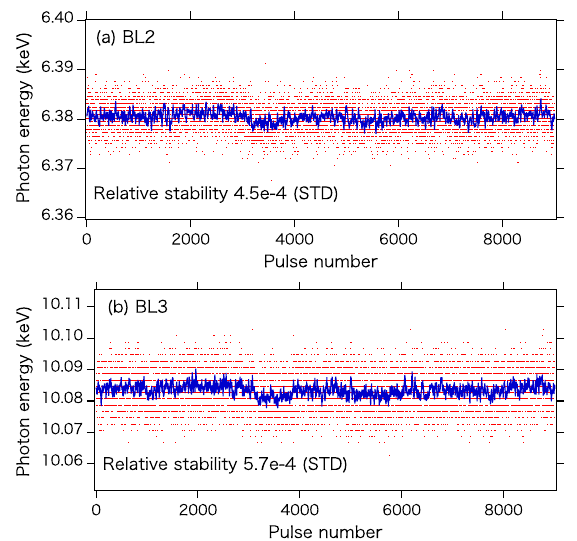
FIG. 10. Stability of the central photon energy measured by a wavelength monitor [22] in the multi-beam-line operation, (a) BL2 and (b) BL3. Red points represent single-shot results and blue lines show averaged values over 15 shots. The pulse repetition at each beam line was 15 Hz and the full horizontal scale corresponds to 10 min. The electron beam energy was 7.8 GeVand the undulator K-values were 2.85 and 2.1 for BL2 and BL3, respectively. The peak current is 1.2 kA for both beam